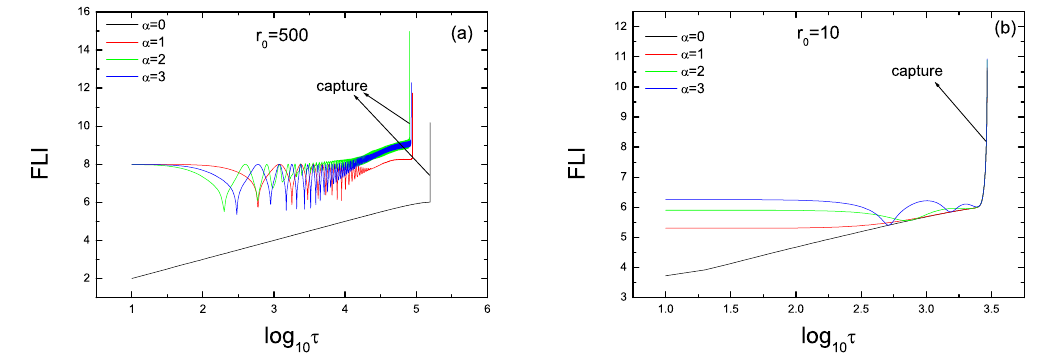
Figure 9 . FLIs with di(cid:11)erent (cid:11) for r 0 = 500 (left plot) and r 0 = 10 (right plot). Here, we set z = 1, T = 0.